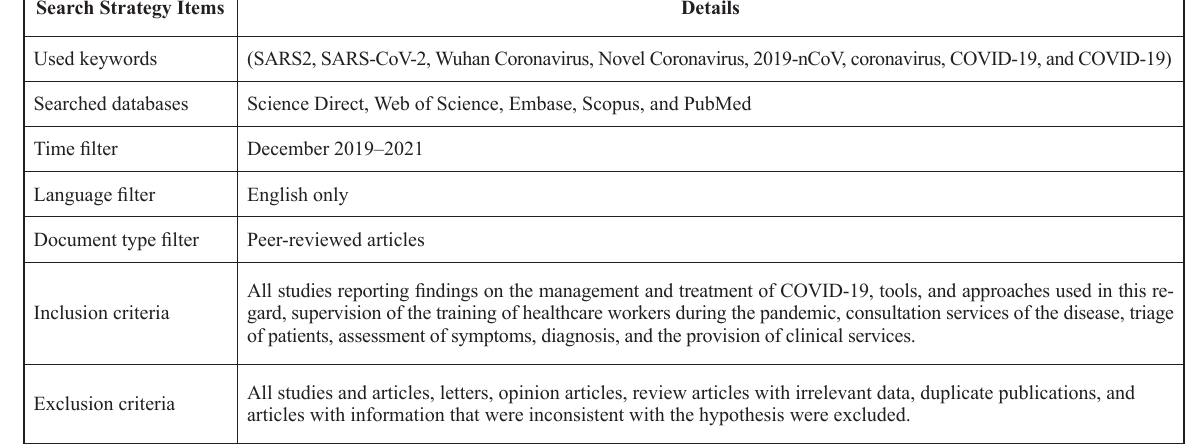
Table 1. Details of the search strategies used in the current review Search Strategy Items